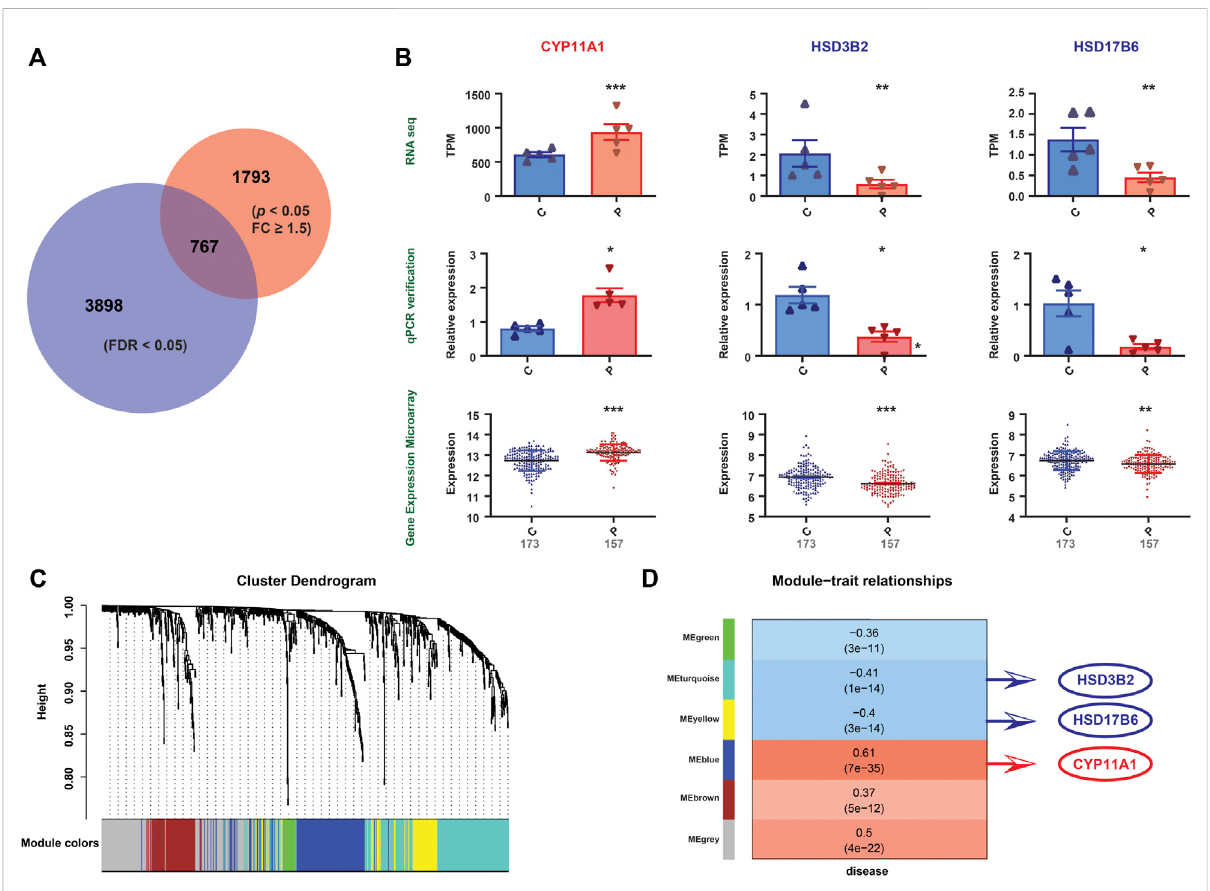
FIGURE 4 Validationofthegeneexpressionpatterns. (A) DifferentialgeneexpressionbetweenthePEandcontrolgroupsfromRNA-seqdata(indicatedby the red circle). Differential gene expression between the PE and control groups from mRNA expression pro fi le microarray datasets (indicated by the bluecircle).TheVenndiagramrepresentstheintersectionbetweenthetwosets (767genes). (B) Amongthe767 genes,threedifferentiallyexpressed genes( CYP11A1,HSD3B2 ,and HSD17B6 ),whichcorrelatewithsteroidhormonebiosynthesis,werealtereduniformlyintheRNA-seqdata,qPCR validationandmRNAexpressionpro fi lemicroarraydatasets.Signi fi cantdifferences,*: p < 0.05,**: p < 0.01,***: p < 0.001. (C) The fi guredemonstrates the differentially expressed gene cluster dendrogram analysis in the preeclampsia vs. control groups. The fi ve colors, namely, green, turquoise, yellow, blue, and brown, represent the modules. The dynamic tree cut method was implemented for analysis. The degree of coexpression between the genes assigned by the same module was relatively high. (D) The fi gure represents the correlation between mRNA module eigengenes and phenotypic traits. Each row represents the module eigengene or ME (ME is the correlation matrix of the module and sample, labeled by color), and each column represents a trait. Each square contains Pearson ’ s correlation coef fi cient between the MEs and traits and their associated p values. The red and blue colors show a strong positive and negative correlation, respectively. The HSD17B6 , HSD3B2 and CYP11A1 genes are located in three modules, that is, turquoise, yellow, and blue, respectively. These three modules are highly correlated with